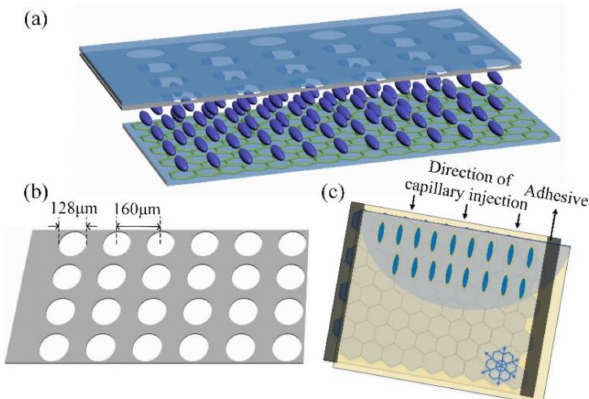
Figure 2. ( a ) The schematic of the proposed electrically controlled liquid crystal microlens array (EC-LCMLA). ( b ) The structure parameters of the patterned Al electrode. ( c ) Capillary injection process of LC molecules, noting that the patterned Al electrode was not shown.